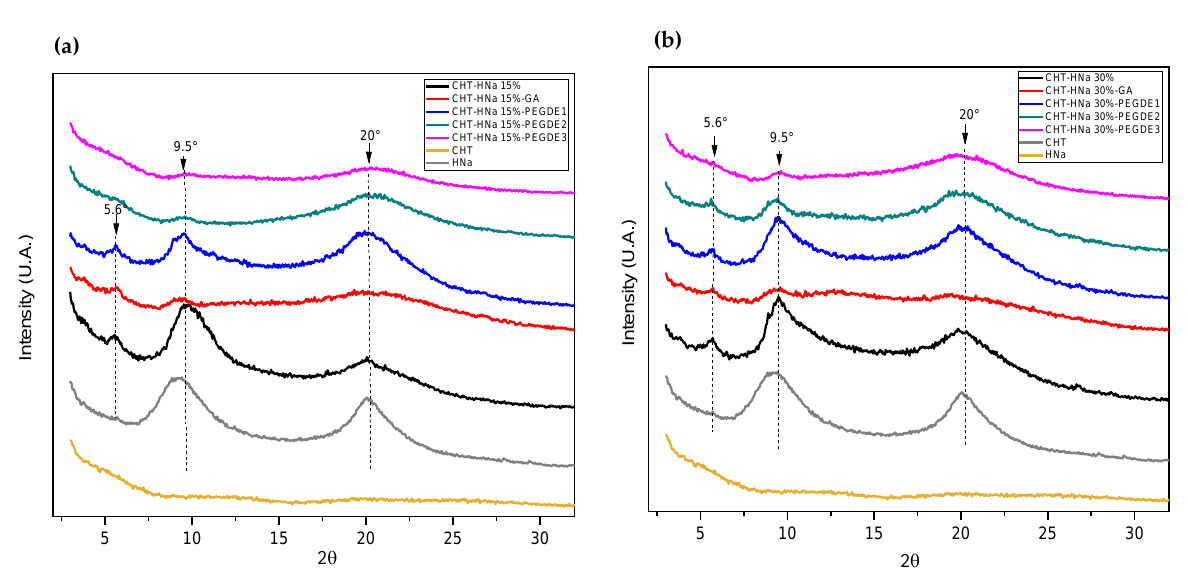
Figure 4. XRD pattern of GA crosslinked and PEGDE crosslinked chitosan/HNa films. HNa content of 15% ( a ), HNa content 30% ( b ).